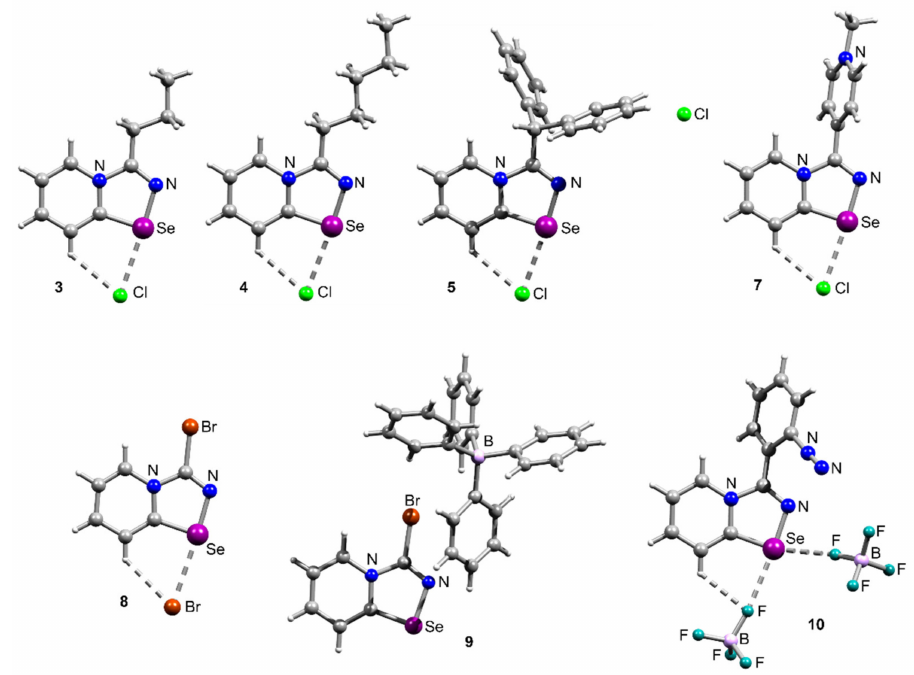
Figure 1. Ball-and-stick representations of the crystal structures of 3 – 5 and 7 – 10 . Grey and light-grey spheres represent carbon and hydrogen, respectively.